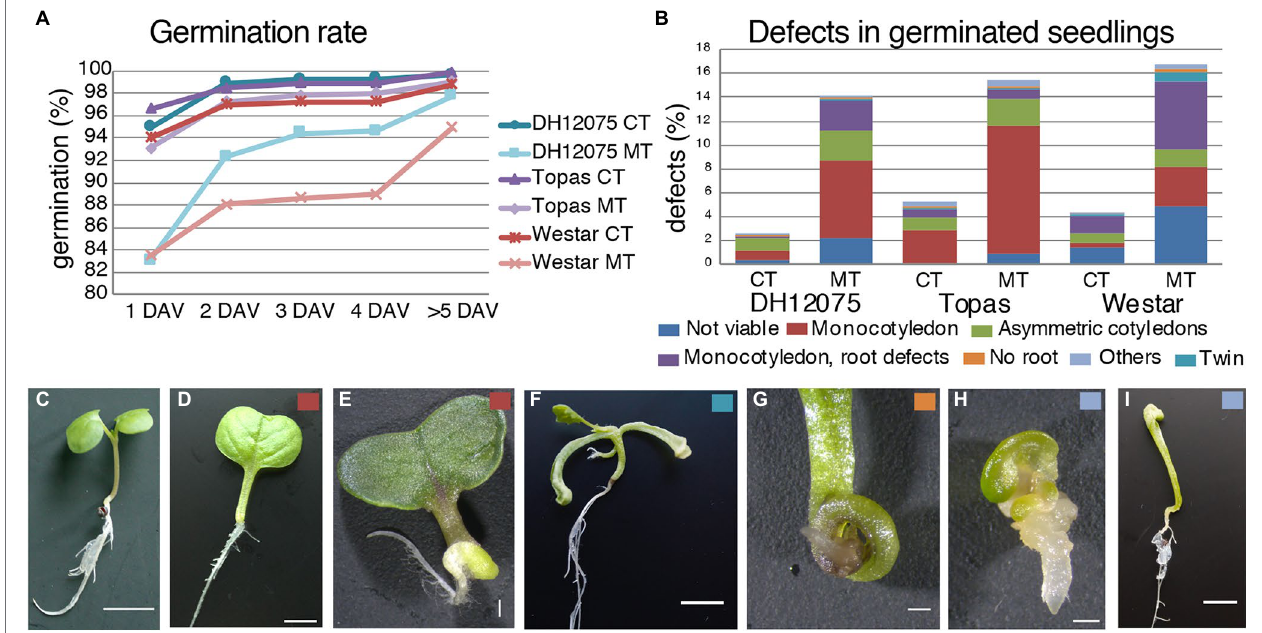
FIGURE 8 | Seed development at high temperatures affects seedling viability. (A) Graph displaying the cumulative percentage of seed germination at 1, 2, 3, and 4 day after vernalization (DAV), and later for seeds produced by DH12075, Topas, Westar plants grown at CT and MT. (B) Percentage of defective seedlings per categories of defects: not viable (dark blue), with one cotyledon (red), asymmetrically positioned cotyledons (green), twin seedlings (turquoise), with one cotyledon, and defective root (purple), without any root (orange) and other categories (light blue). The analysis was performed on seedlings from seeds produced by DH12075, Topas, Westar plants grown at CT and MT. (C–I) Range of observed seedling phenotypes. A wild-type seedling is shown (C) . Seedlings (D,E) are with one cotyledon (red). (F) The seedling is with two roots and two shoots (turquoise). (G) Zoom in of a seedling without root (orange). (H,I) Are shown seedlings from the other categories (light blue). The small colored square in the upper right corner refers to the categories. Scale bars represent 10